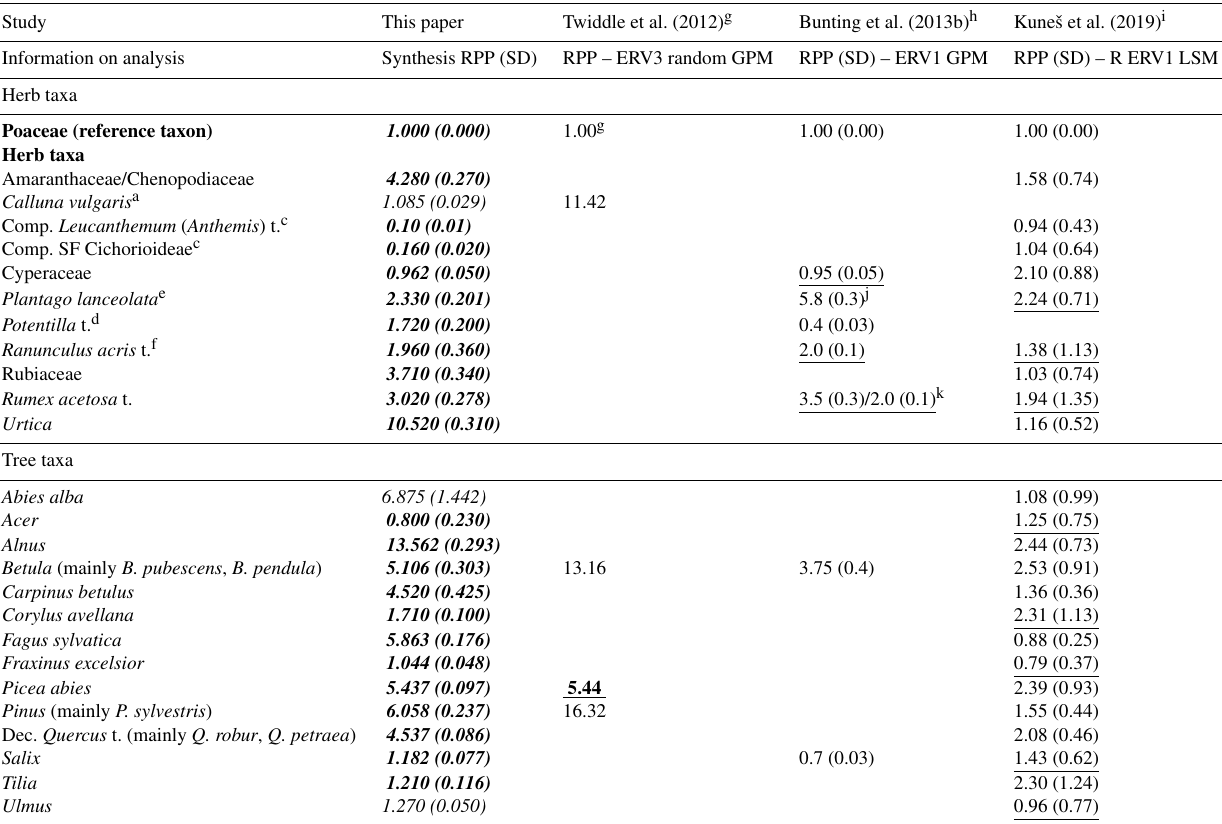
Table A2. Comparison of the mean RPPs in this synthesis with the RPP estimates from Britain (Twiddle et al., 2012), Greenland (Bunting et al., 2013b) and Czech Republic (Kuneš et al., 2019). RPP values are obtained using the extended R value (ERV) model (1 and 3 being two of the three existing ERV sub-models) and different models of pollen dispersion and deposition (or distance-weighting methods), here the Gaussian plume model (GPM) and the Lagrangian stochastic model (LSM) (see “Methods” in Appendix B and caption of Table C1); random: distribution of pollen samples in the study; R: ERV model implemented with an R code. Explanations for symbols a–f in the taxa list are in the caption below Table A1. The RPP and SD values in italic are the mean RPPs used in the new REVEALS reconstruction for Europe (this paper); values in bold are new values, and values not in bold are the same values as in Mazier et al. (2012). Underlined values are values from the three published studies that are close to the values of the synthesis in this paper. g The original paper does not provide an RPP for Poaceae and SDs for the RPPs. We extracted the RPP values related to Picea from Table 5 in Twiddle et al. (2012). RPPs related to Poaceae (1.00 g ) were then calculated by assuming that the RPP of Picea was equal to the mean RPP of Picea in Europe (this synthesis) (in bold). h The RPPs and their SDs are not listed in the original paper; we therefore extracted the values from Fig. 4 in Bunting et al. (2013b), and the decimals are approximate. i Kuneš et al. (2019): we chose the RPP values that were considered best by the authors, i.e. using the lake dataset (pollen from lake sediment), ERV sub-model 1 and the Lagrangian stochastic model (for details, see “Discussion” section in this paper). j Value for Plantago maritima and k two values for Rumex acetosa and Rumex acetosella , respectively (Bunting et al., 2013b), for comparison with Plantago spp. and Rumex acetosa t. (this